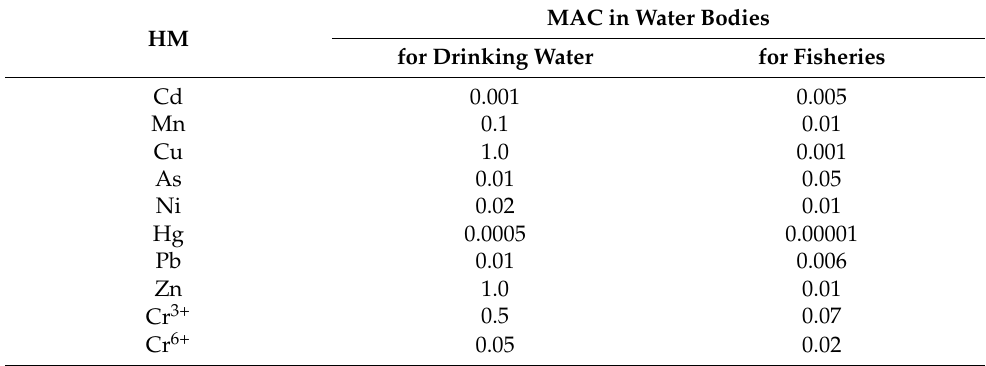
Table 1. Maximum allowed concentrations (MAC) for some heavy metals (HM) in the Russian Federation (mg · L − 1